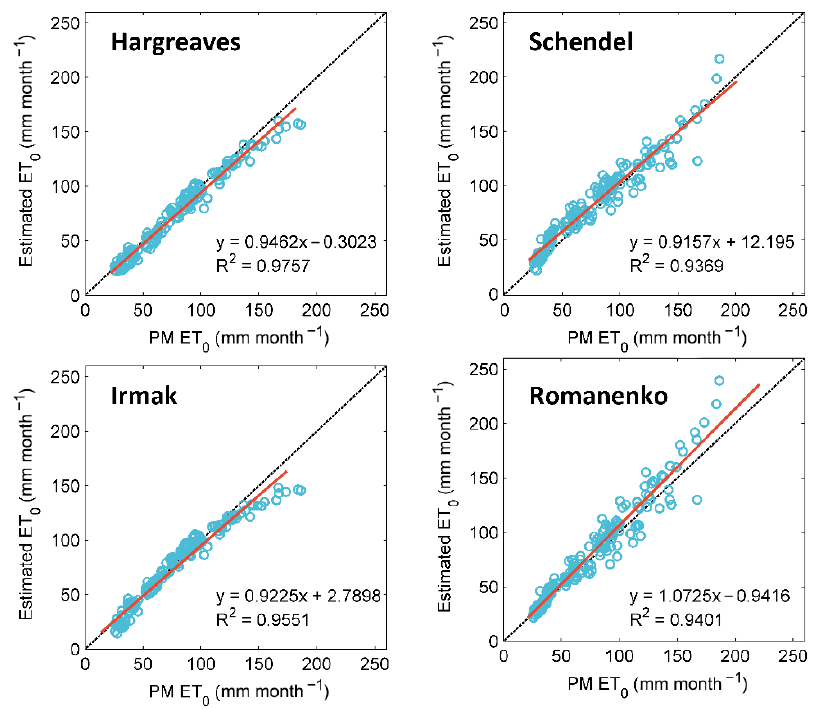
Figure 4. Scatter plots of ET 0 values estimated by the four empirical models against FAO-56 PM ET 0 values at Shapinba station during the testing period.